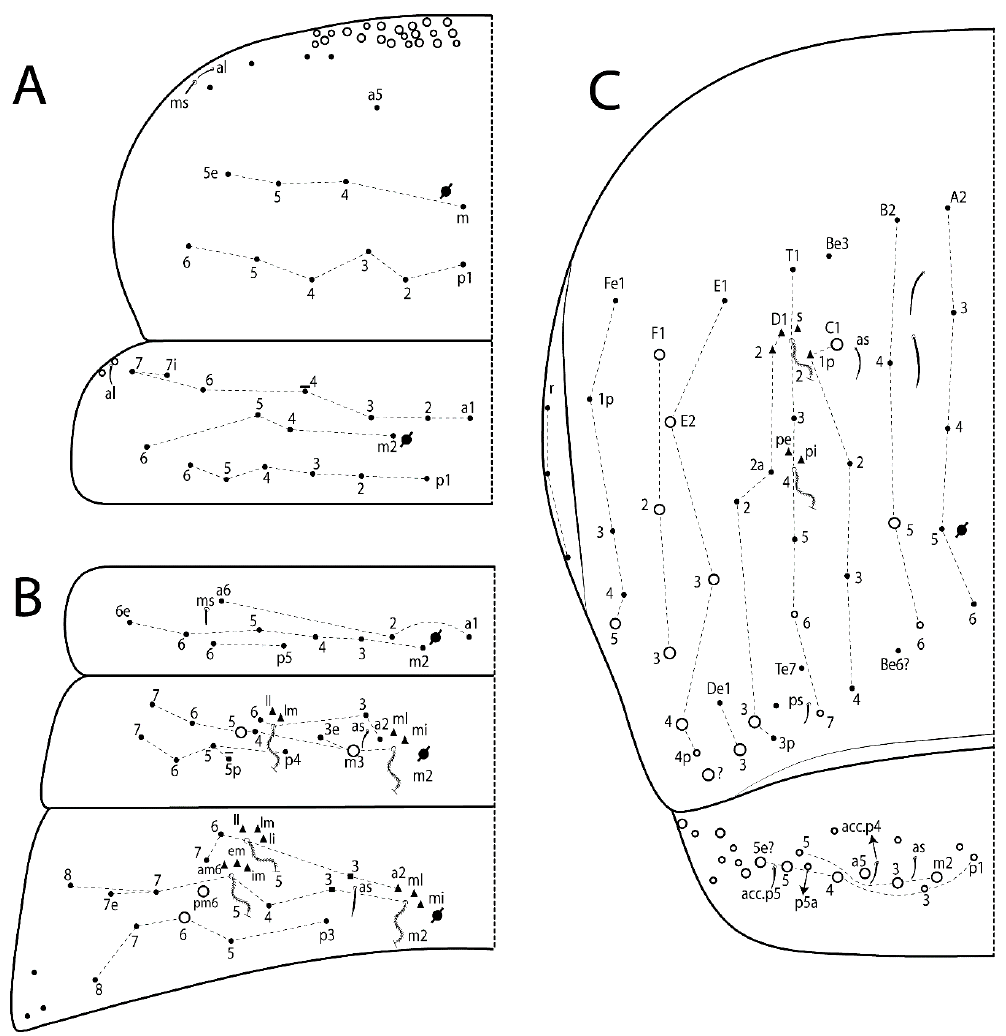
Figure 59. Pseudosinella pusilla sp. nov.: dorsal chaetotaxy. ( A ) Th II–III; ( B ) Abd I–III; ( C ) Abd IV–V.